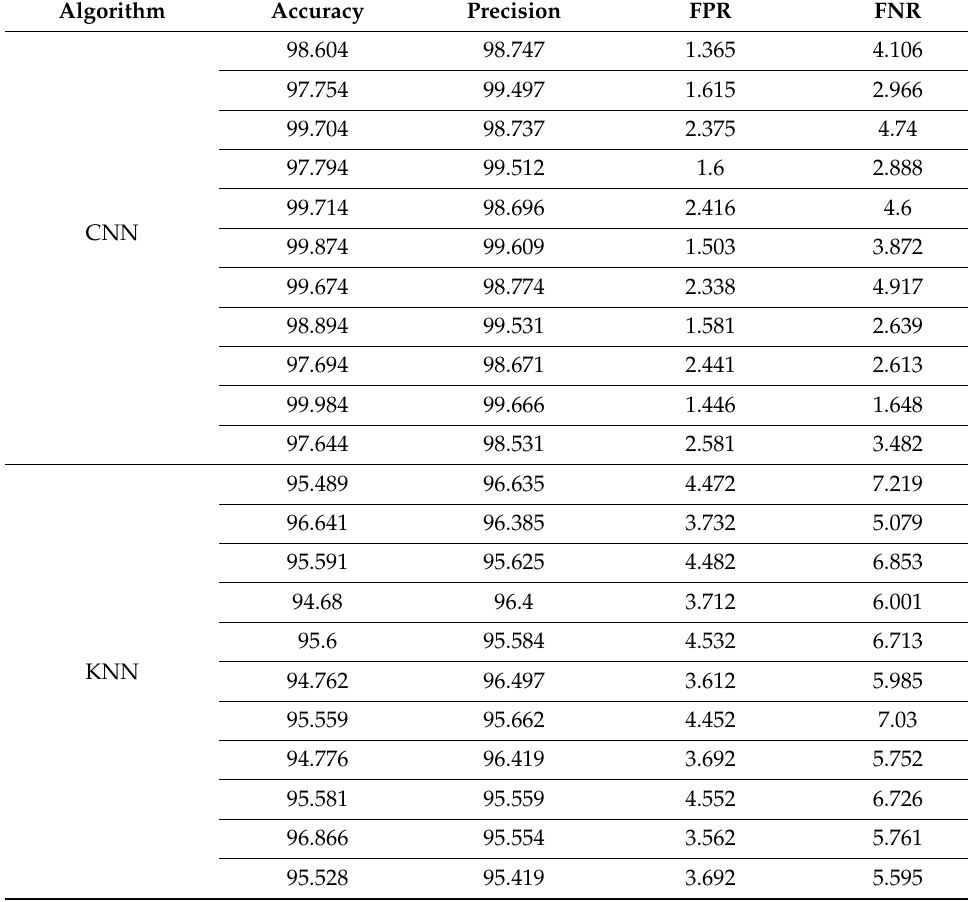
Table 4. Iteration values of performance measuring parameters.